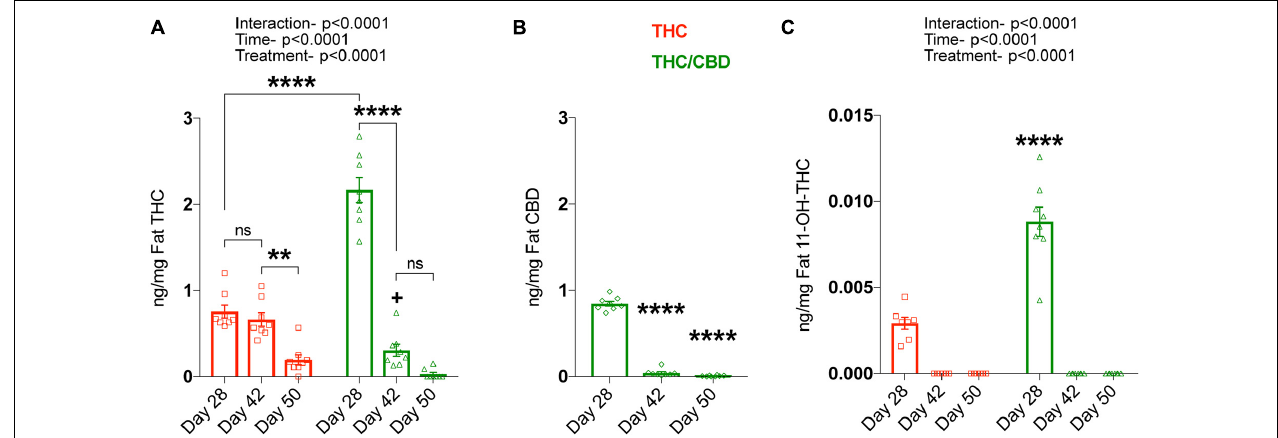
FIGURE 3 | CBD inhibits THC metabolism. Fat THC and its metabolites as well as CBD concentrations were determined at various time-points, on the last treatment day (day 28), 2 weeks post-treatment (day 42), and 3 weeks post-treatment (day 50). (A) Fat THC levels were significantly altered based on time and the type of treatment. Data represented as mean ± SEM, ** p < 0.01; **** p < 0.0001; + p < 0.05 (difference in fat THC levels at day 42 between THC and THC/CBD groups); 2-way ANOVA with Tukey’s multiple comparison test. (B) Fat CBD concentrations in the THC/CBD group significantly decreased over-time. Data represented as mean ± SEM, **** p < 0.0001 (difference in fat CBD levels between day 28 and day 42 or day 50); 1-way ANOVA with Tukey’s multiple comparison test. (C) Increased fat 11-OH-THC, metabolite of THC in the presence of CBD at day 28. No fat THC metabolites are detected at day 42 and day 50 ( n = 7–8 mice per group). Data represented as mean ± SEM, **** p < 0.0001 (difference in fat 11-OH-THC levels at day 28 between THC and THC/CBD groups); 2-way ANOVA with Tukey’s multiple comparison